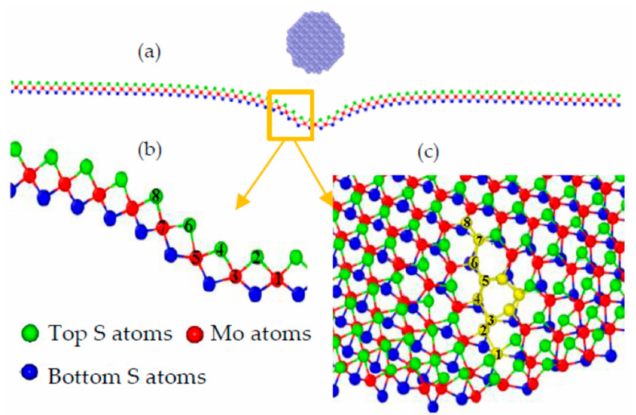
Figure 3. The atomic configuration at the cross section of the deformed SLMoS2 ( a ); the labeled atoms in the distorted area ( b ); the zoom in view of the residual hollow ( c